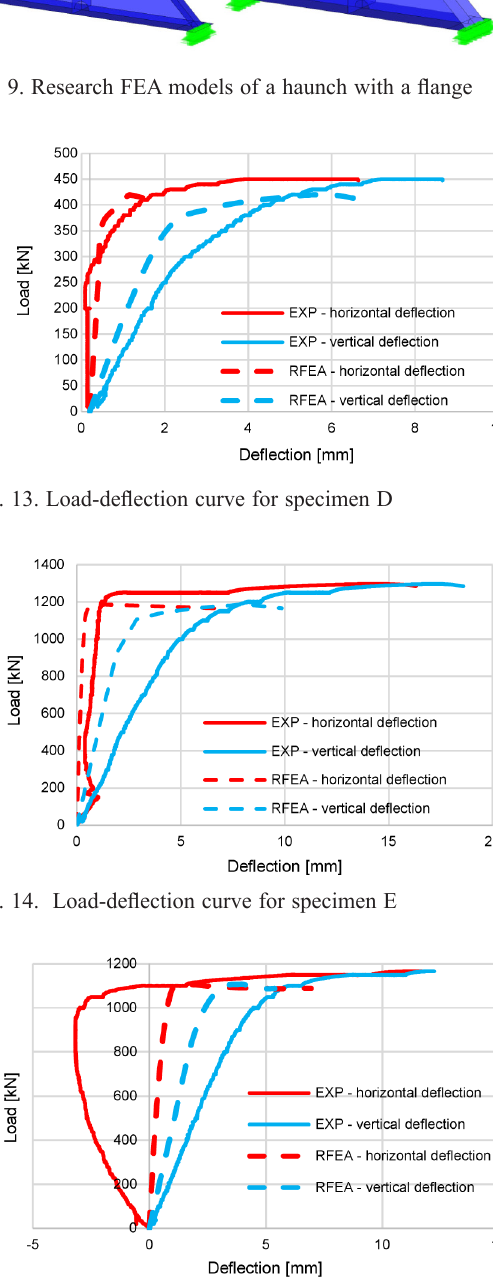
Fig. 15. Load-deflection curve for specimen